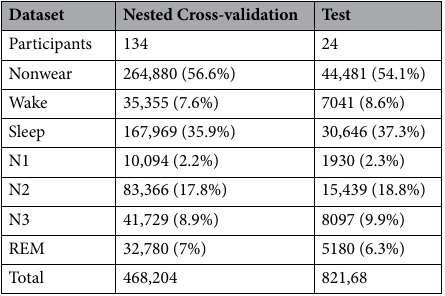
Table 1. Samples per class in the data (Percentages in